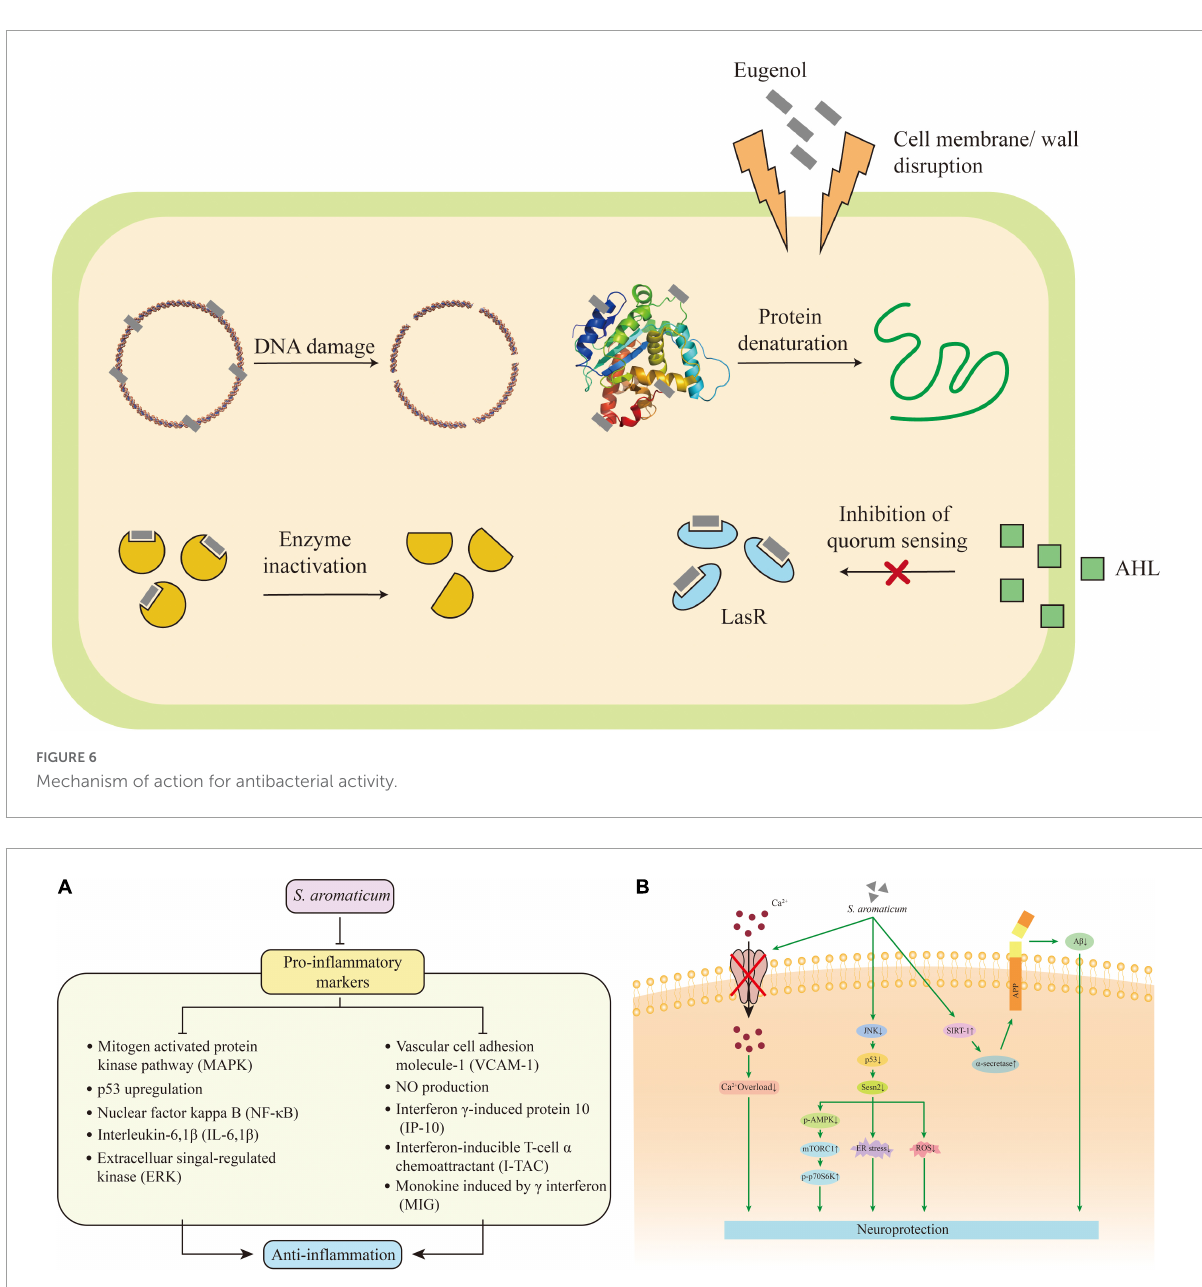
FIGURE7 Mechanism of action for the immunomodulatory (A) and neuroprotective (B) activity.